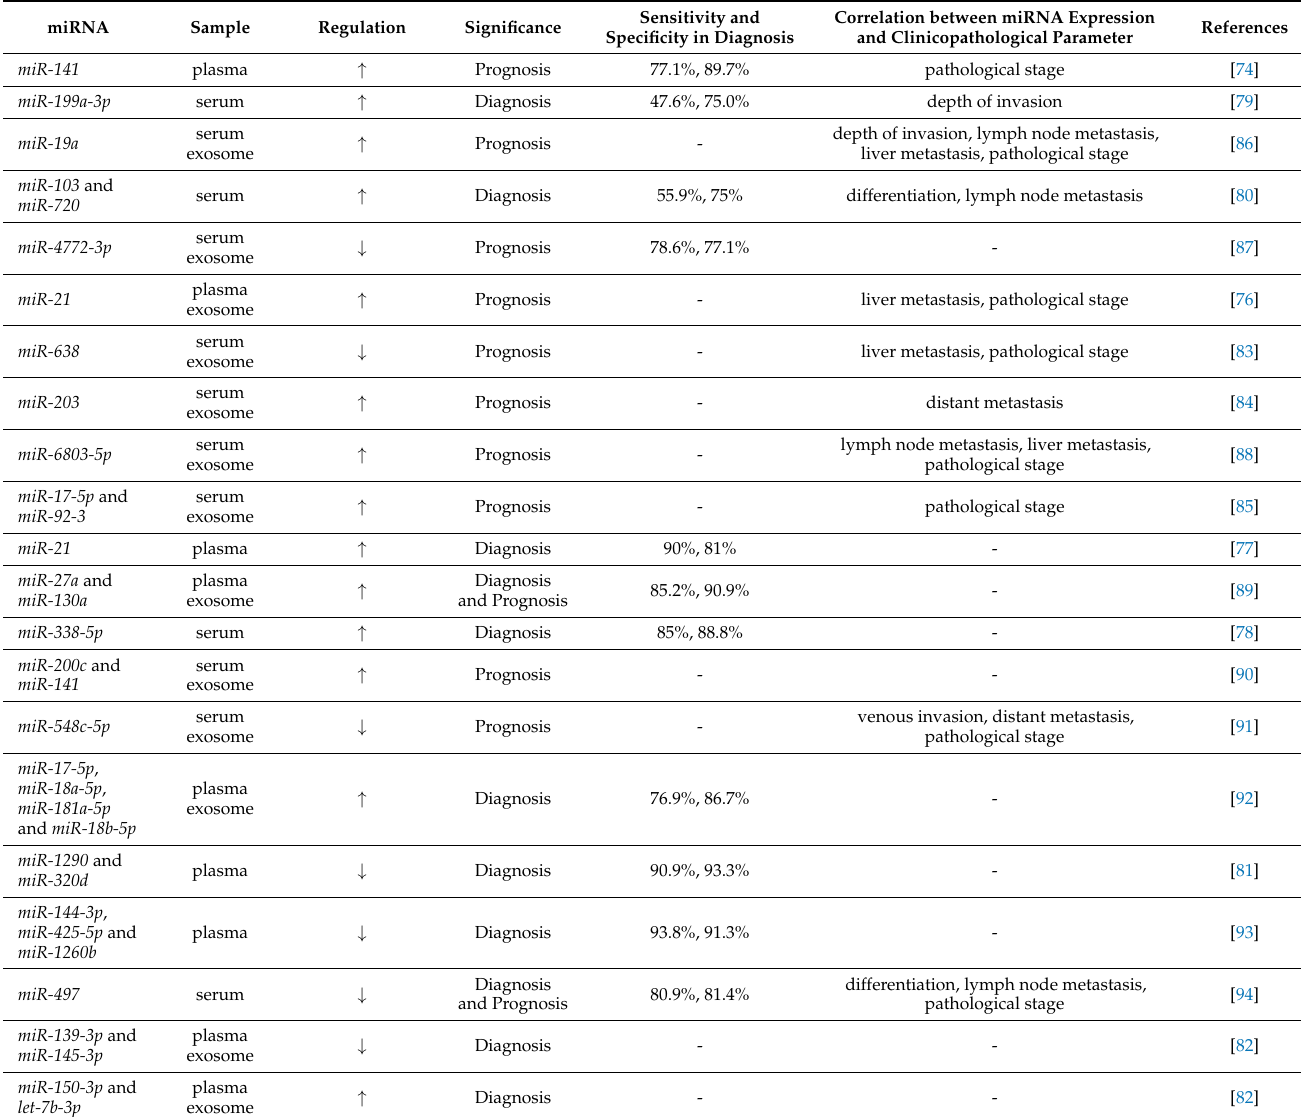
Table 3. Colorectal